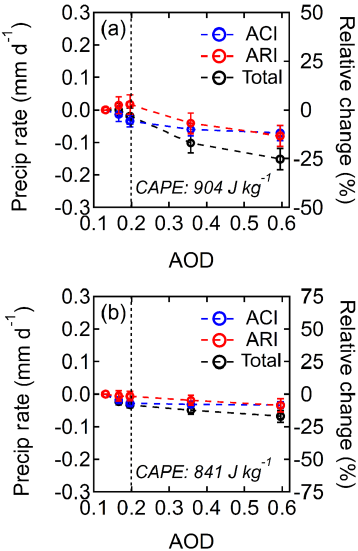
Figure 10. Changes in domain-averaged precipitation rate with increasing BB emission intensity (indicated by domain-averaged AOD in each emission scenario) in (a) the intensive precipitation regime and (b) light precipitation regime. The vertical dotted line in each plot indicates the EMIS1 scenario. Error bars denote the standard